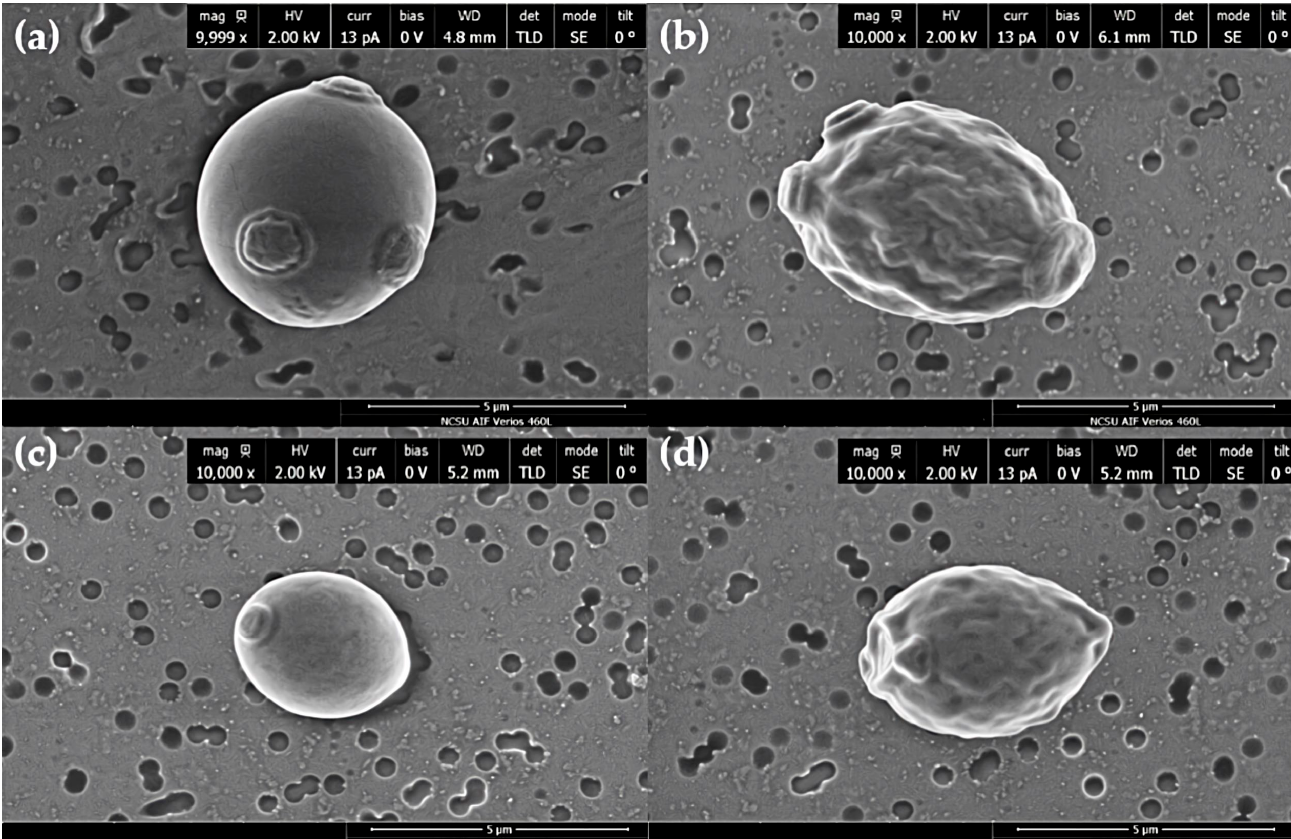
Figure 4. SEM micrographs of NS commercial and NS naïve yeast at 10,000× magnification. ( a ) and ( c ) are NS commercial and NS naïve yeast exposed to 0 mg/L AgNO 3 , respectively. ( b , d ) are NS commercial and NS naïve yeast exposed to 22.5 mg/L AgNO 3 , respectively.